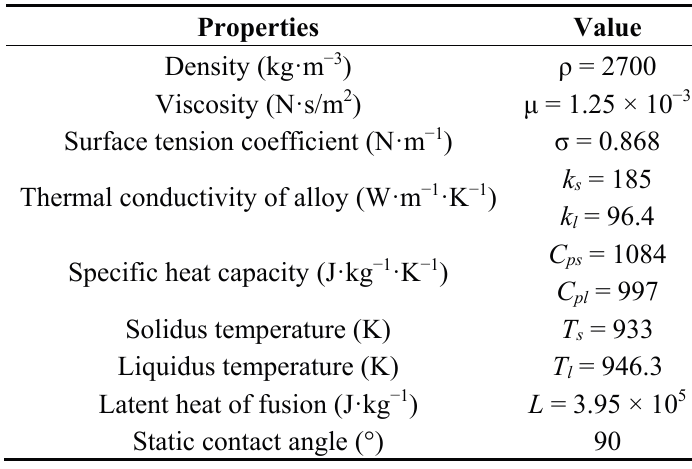
Table 2. Properties of aluminum alloy used in this